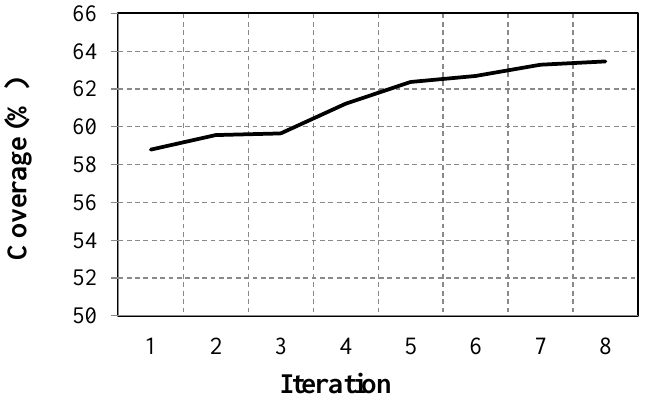
Figure 11. Coverage improvement over iterations of the context-aware